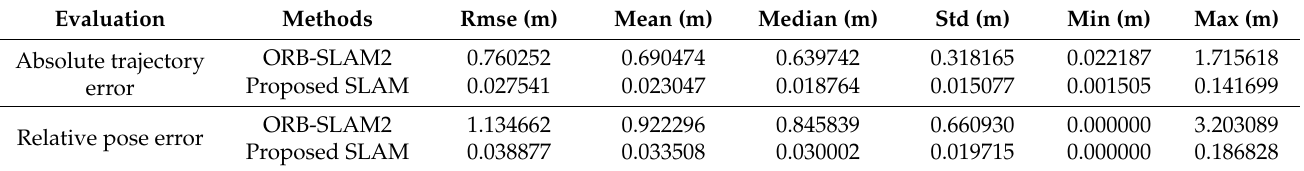
Table 5. Pose error representative value of dataset one.